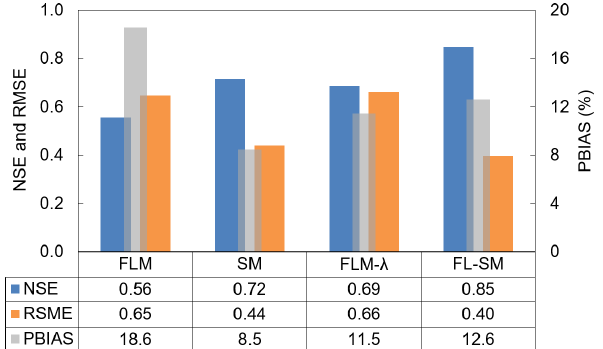
Figure 11. Model evaluators: NSE, RMSE and PBIAS. The bar plot shows the performance of all tested models; the PBIAS values are given in percent.